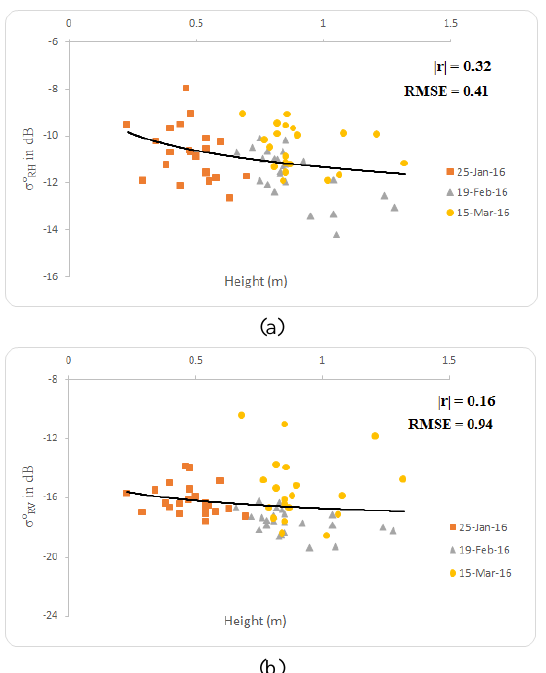
Figure 4. Scatterplot of backscattering coefficients [(a): σ° RH ; (b) σ° RV ] vs wheat